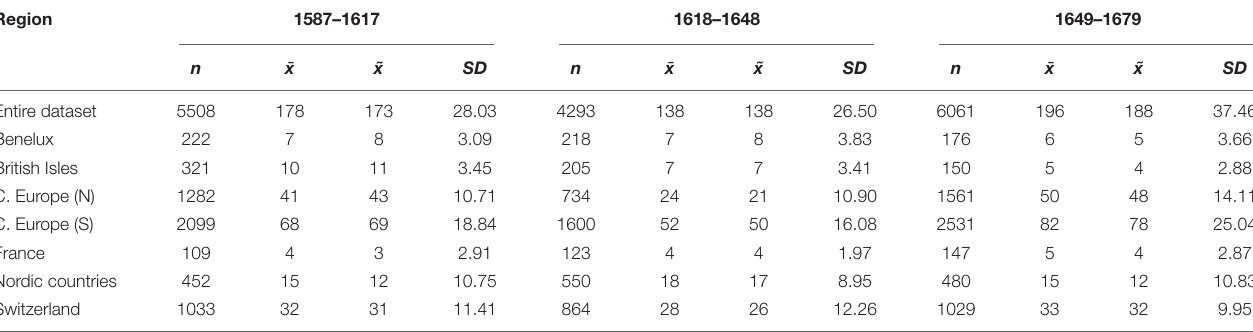
TABLE 5 | Summary statistics for the felling dates for the 31-year periods around the Thirty Years’ War (1618–1648) including the number ( n ) mean ( ¯x ), median ( ˜x ) and standard deviation ( SD ).